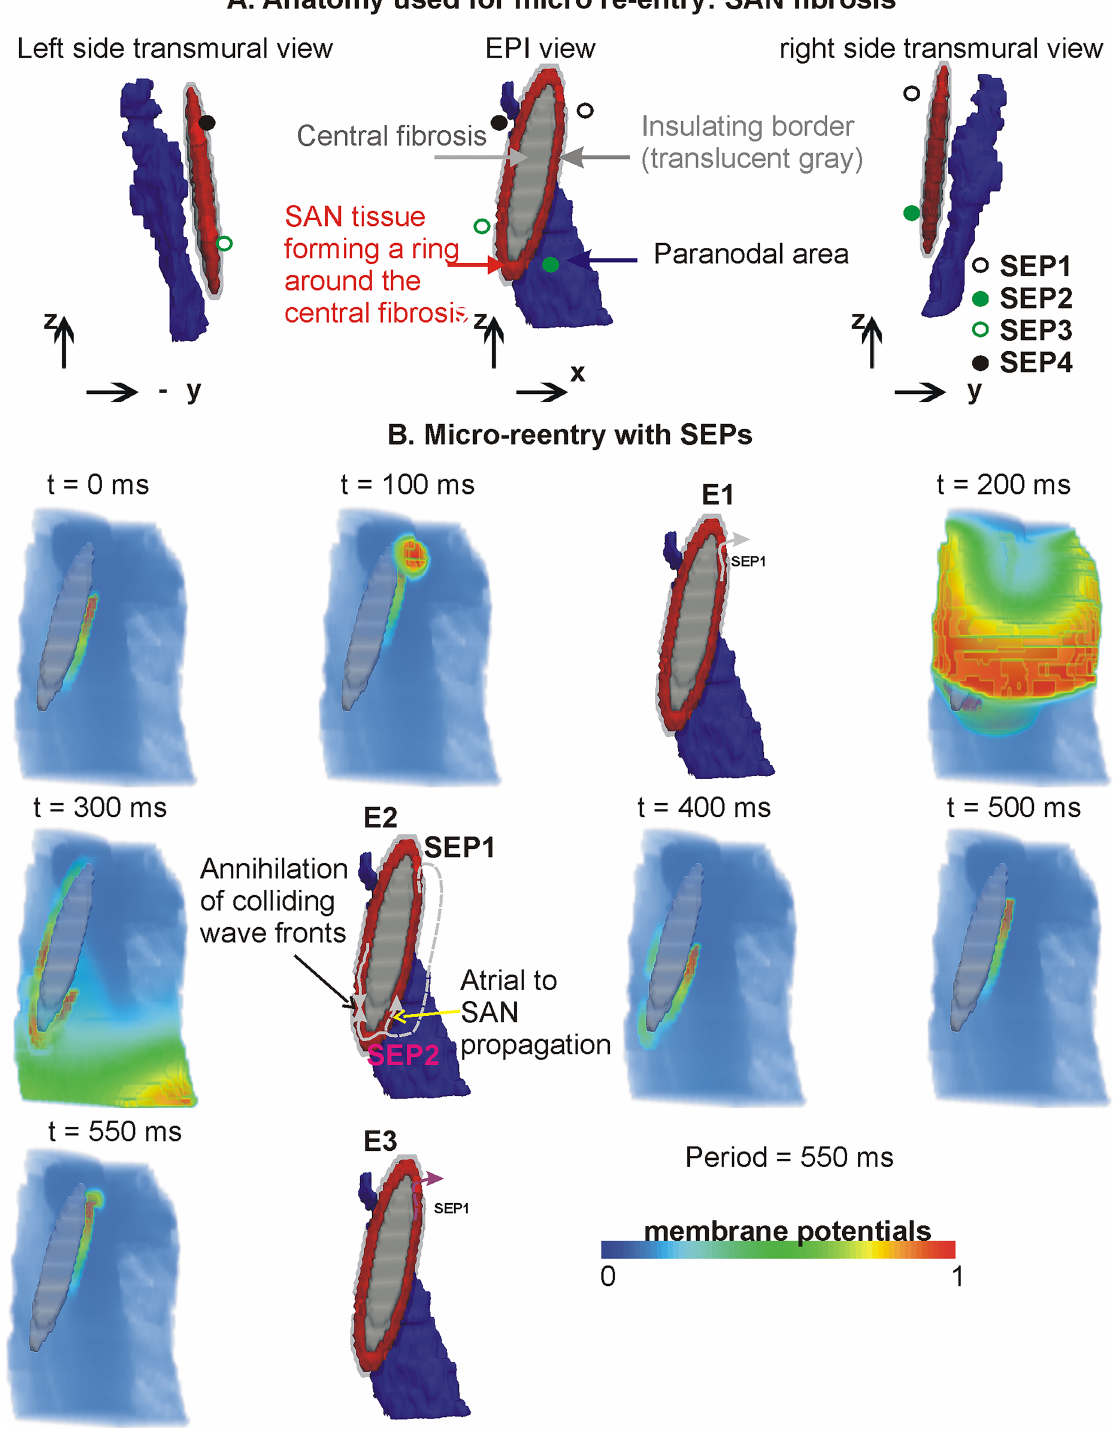
Fig 5. Evolution of micro re-entry in the full model with SEPs. A: Anatomy (similar to Fig 4A) of the SAN, SAN fibrosis, and locationsof functionalSEPs. B: Consecutive time frames of the micro re-entry in terms of voltage distribution interspersed with panelsillustratingthe important events that occur duringone periodof the re-entry. E1 illustrates the SAN propagationinitiating excitation in the atrium. E2 illustrates the directions of propagationfrom the atrium into the SAN, as well as the annihilationand continuing of the SAN re-entry. E3 marks the completionof one period of the